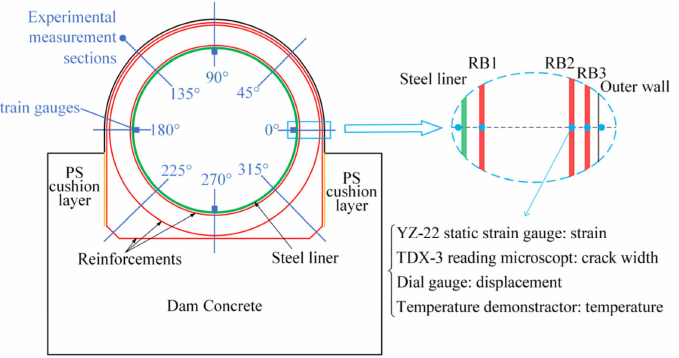
Figure 4. Longitudinal section schematic of the steel-lined reinforced concrete